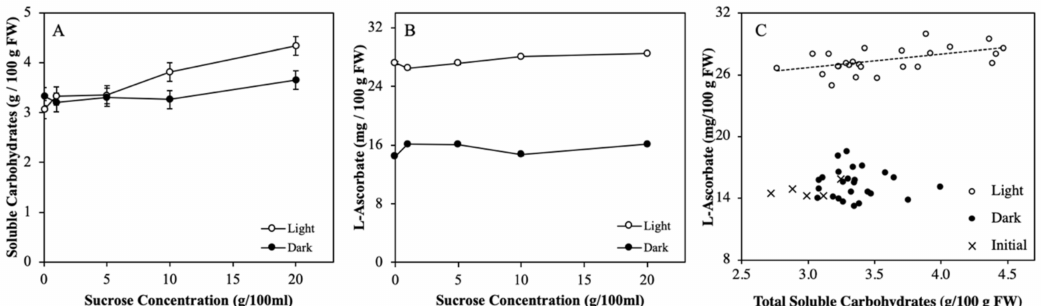
Figure 5. E ff ect of sucrose feeding on fruit total soluble carbohydrate content (sum of sucrose, fructose, and glucose ( A ) and ASC content ( B )) in tomato when detached immature green fruits were fed with 5 di ff erent sucrose concentrations during 7 days of ripening until red in light and darkness. Correlation between ASC and soluble carbohydrates content for fruits in light and darkness ( C ). Line in C represents a linear fitting of data points of the light treatment. Each data point is based on pooled sample of pericarp discs of 2 fruits. Error bars represent standard errors of means, α = 0.01; n = 5; Experiment 4). Error bars in Figure B are smaller than symbol